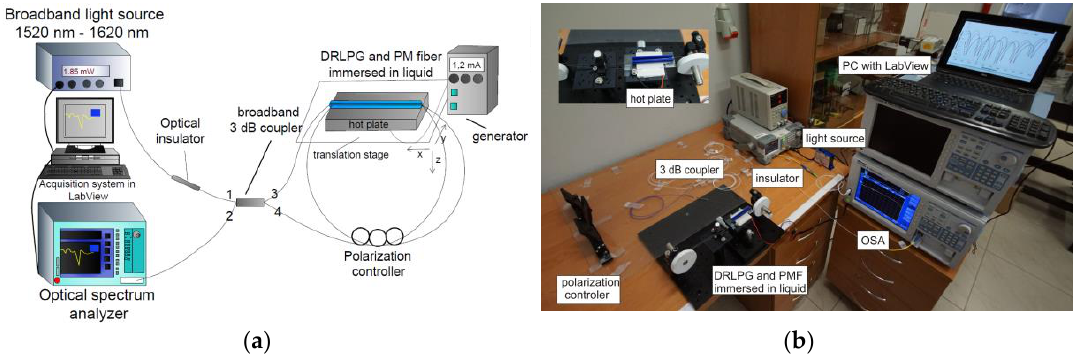
Figure 1. The schematic ( a ) and general photo ( b ) of experimental setup for the ambient refractive-index (RI) and temperature measurement sensor with emphasized the polarization controller (PC) position.